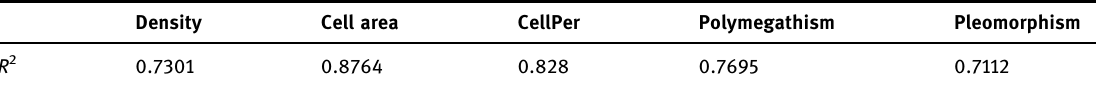
Table 1: R 2 values